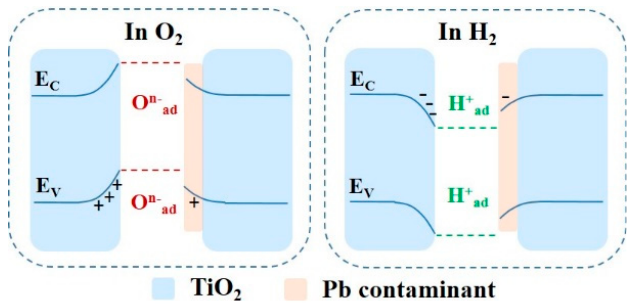
Figure 6. Schematic diagram of the influence mechanism of Pb on the TiO 2 grain boundary barrier.